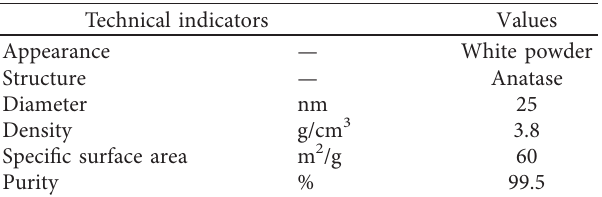
Table 2: Technical indicators of nano-TiO